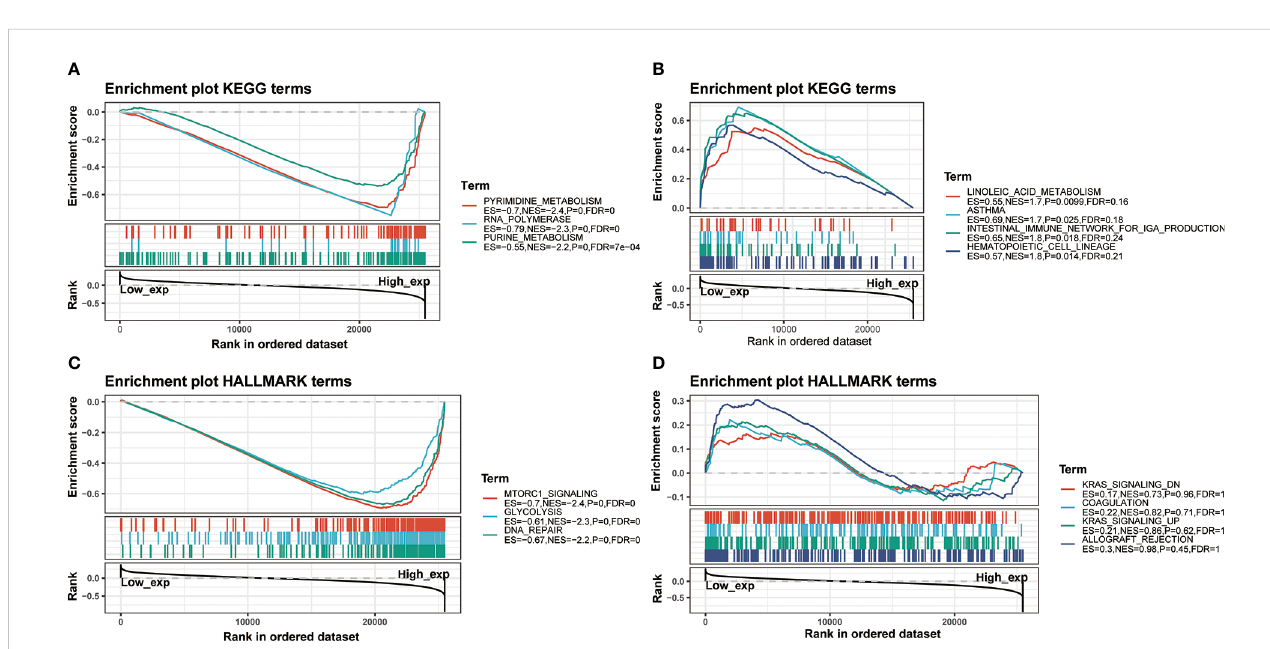
FIGURE 12 GSEA for samples with high IGF2BP3 expression and low expression. (A) The enriched gene sets in KEGG collection by the high IGF2BP3 expression sample. (B) The enriched gene sets in KEGG by samples with low IGF2BP3 expression. (C) Enriched gene sets in HALLMARK collection, the immunologic gene sets, by samples of high IGF2BP3 expression. (D) Enriched gene sets in HALLMARK by the low IGF2BP3 expression. Each line represented one particular gene set with unique color, and up-regulated genes located in the left approaching the origin of the coordinates, by contrast the down- regulated lay on the right of x-axis. Only gene sets with NOM p < 0.05 and FDR q < 0.25 were considered statistically signi fi cant. And only the leading- edge genes were